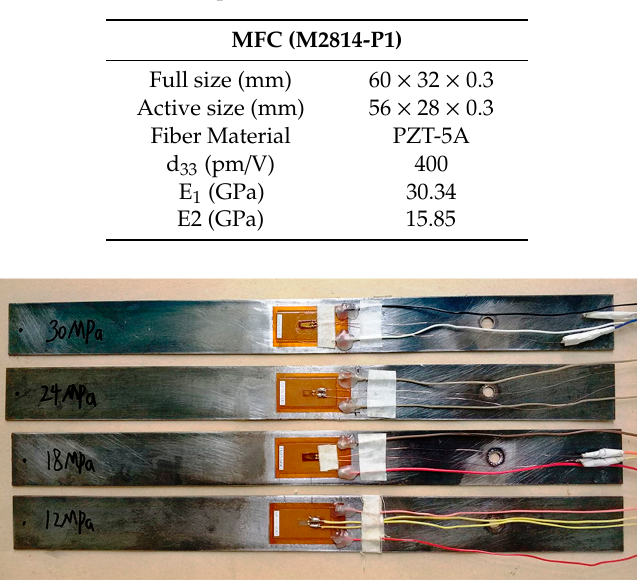
Table 1. Properties of the MFC actuator [15].